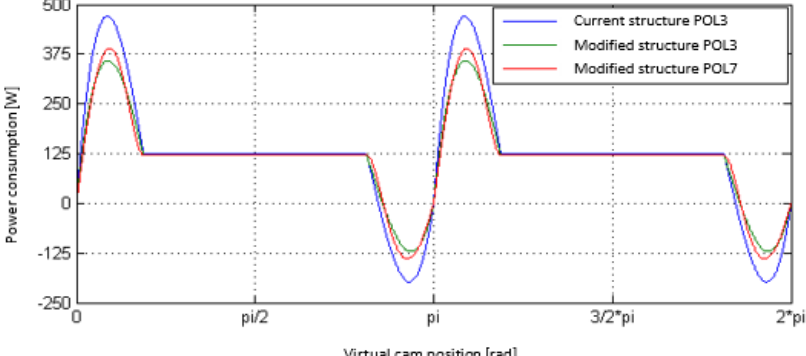
Figure 14. Course of power inputs during one period of reverse motion of the P1 drive of the investigated systems, application of polynomials of the 3rd and 7th degree in the lift dependences describing the position of the cylinder.